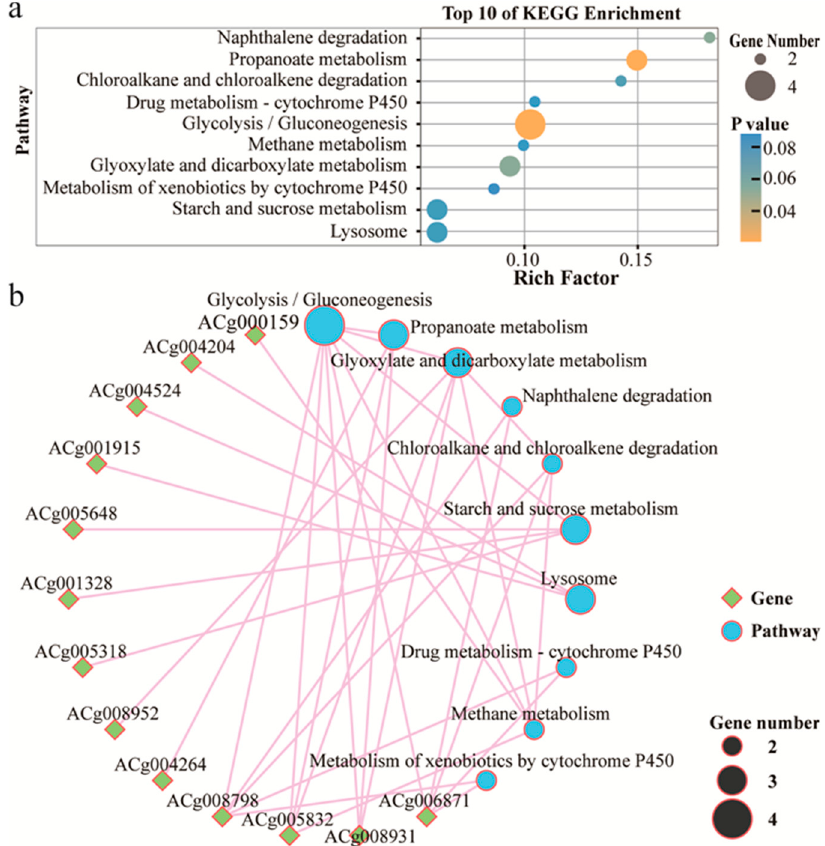
Figure 5. ( a ) Top 10 pathways of KEGG enrichment were detailed. ( b ) A network map of enriched pathways and their DGEs was descripted.